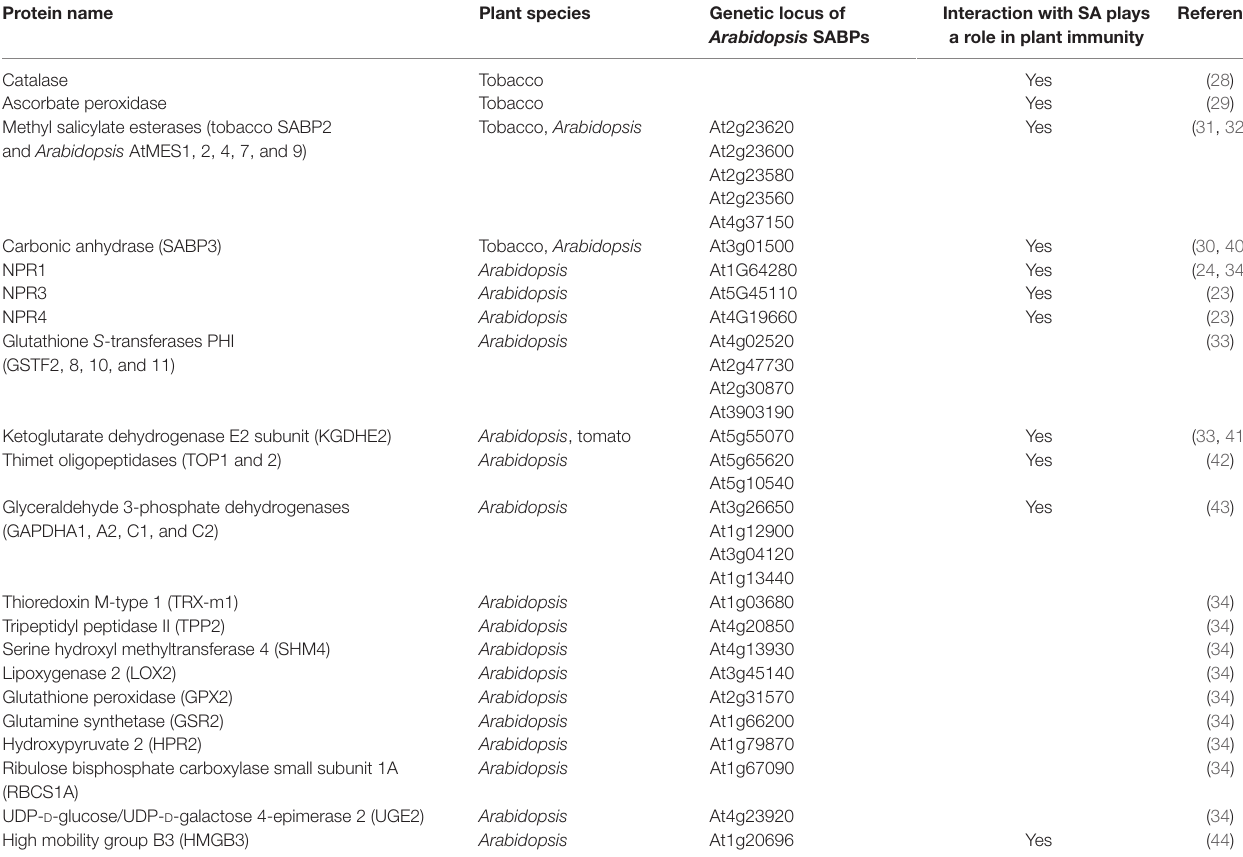
TABLe 2 | List of plant SA-binding proteins (SABPs). Protein name